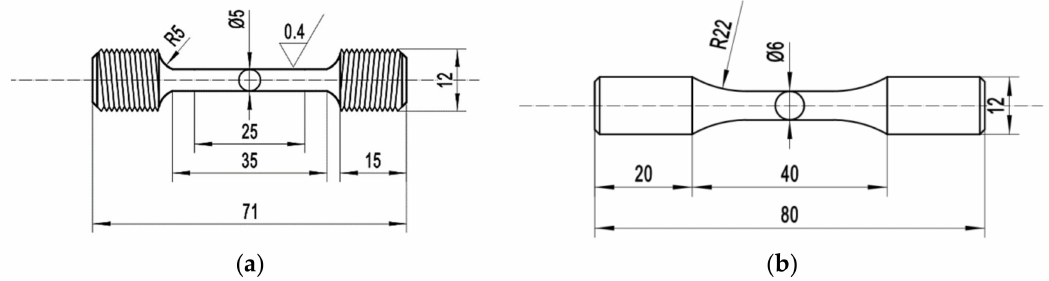
Figure 1. Diagrams of the tensile and fatigue specimens employed in this study (unit: mm). ( a ) Tensile test specimen, ( b ) rotating bending fatigue test